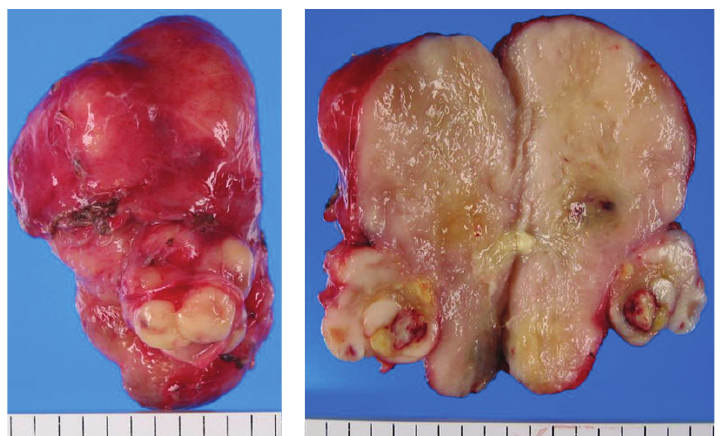
Figure 3: The resected specimen was solid with a smooth surface.